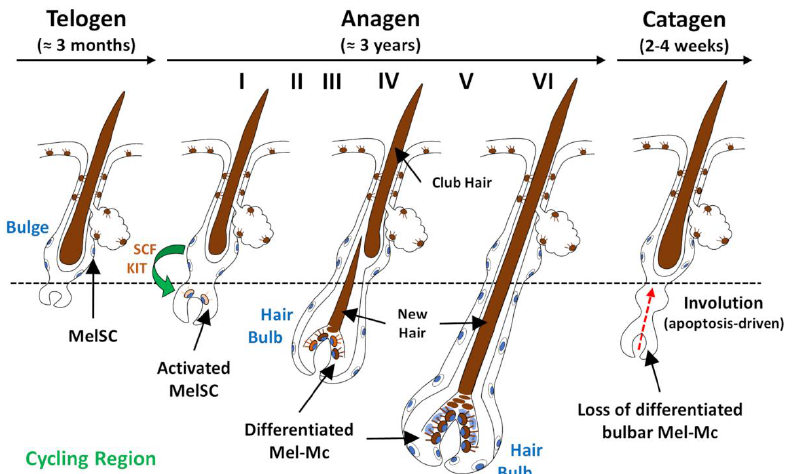
Figure 2. Schematic representation of the fate of melanocytes during the anagen, catagen, and telogen phases of the hair growth cycle. Hair shaft synthesis and pigmentation occur during anagen (or growth phase). Anagen is divided into stages I to VI, throughout which melanocytes experience several morphological and biochemical changes. At the start of anagen, immature melanocytes are stimulated and respond by increasing their volume, entering mitotic activity, and migrating in a coordinate manner, to repopulate the bulb of the new forming hair follicle. By anagen II, melano- cytes are in a state of proliferation, which becomes quite significant at anagen III and remains until anagen VI. During the progression of anagen III into VI, melanocytes increase the size and number of their melanosomes and become highly dendritic. At anagen VI, as proliferation ceases, bulbar melanocytes assume a highly differentiated status and become fully functional with respect to mel- anin synthesis. The catagen phase proceeds through the extensive apoptosis-driven involution of the hair follicle cycling region, followed by telogen, a phase of relative proliferative quiescence. Telogen is characterized by intricate and functionally relevant biochemical activity, focused on the maintenance of several stem cell populations. The active shedding of an old hair fibre (club hair) is a process that occurs as a distinct phase called exogen. KIT: KIT proto-oncogene receptor tyrosine kinase; Mel-Mc: melanogenic melanocytes; MelSC: melanocyte stem cells; SCF: stem cell factor. During the transition from anagen to catagen, tyrosinase is no longer detectable in the hair bulb and the production of melanin is terminated [18,22,55,57]. As the catagen phase proceeds, an extensive apoptosis-driven involution process occurs, causing the loss of up to 70 % of the hair follicle in a relatively brief period (2–4 weeks in the human scalp) [18,22,56,60,61]. The current view suggests that melanocytes are recruited, every new cy- cle, from the base of the permanent part of the hair follicles to populate the hair bulb. This region constitutes a reservoir of immature, slow-cycling, self-maintaining MelSCs that are fully competent to regenerate the pigmentary system of new hair bulbs at the beginning of each anagen phase [17,18,20,54,57,60,61]. Notch signalling, the Wingless-related inte- gration site (Wnt) signalling pathway, paired box 3 (PAX3), MITF, and its downstream target BCL2 have all been proven to play critical roles in the maintenance of these MelSCs by promoting their survival [62–65]. Finally, telogen is a phase of relative proliferative quiescence, and in the human scalp, it lasts around 3 months [18,22]. Despite that, it is characterized by intricate and function- ally relevant biochemical activity, centred around the maintenance of several stem cell